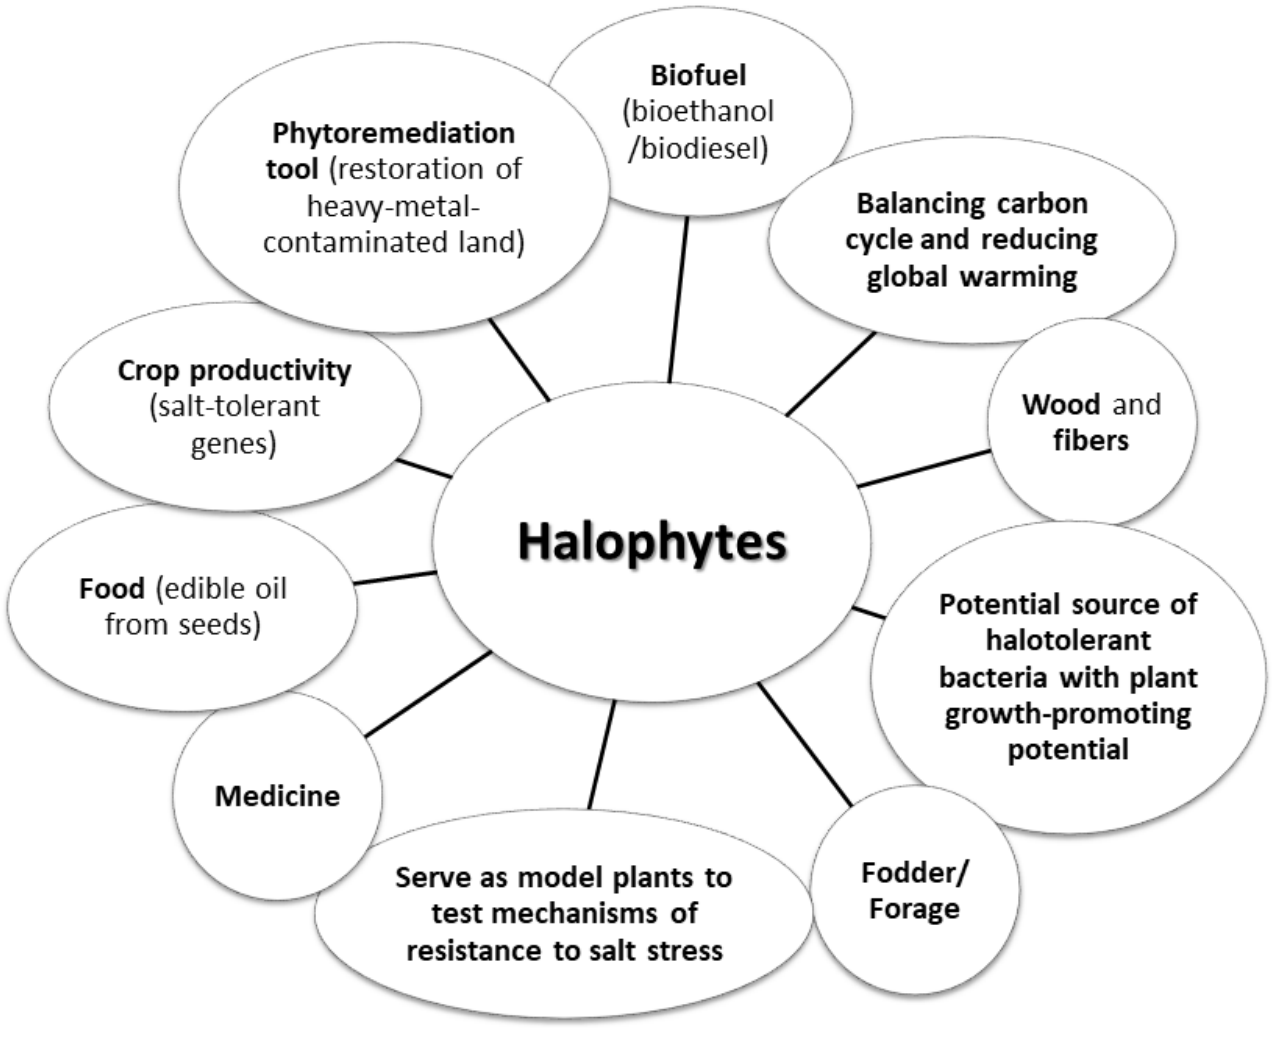
Figure 1. Potential use of halophytes (based [3,4]).